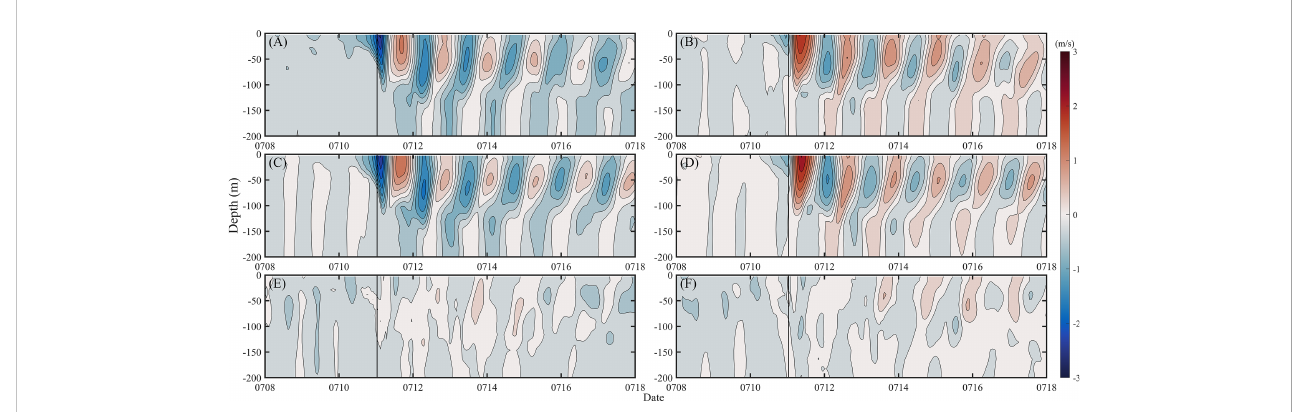
FIGURE 11 The along-track velocity of (A) EXP HYCOM and (C) EXP CLIMAT , the cross-track velocity of (B) EXP HYCOM and (D) EXP CLIMAT , and the difference in the (E) along-track velocity and (F) cross-track velocity between EXP HYCOM and EXP CLIMAT